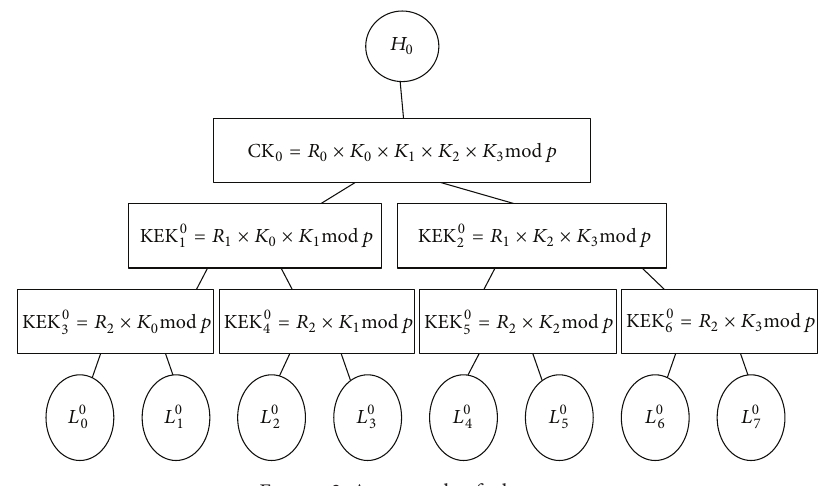
Figure 2: An example of a key tree.